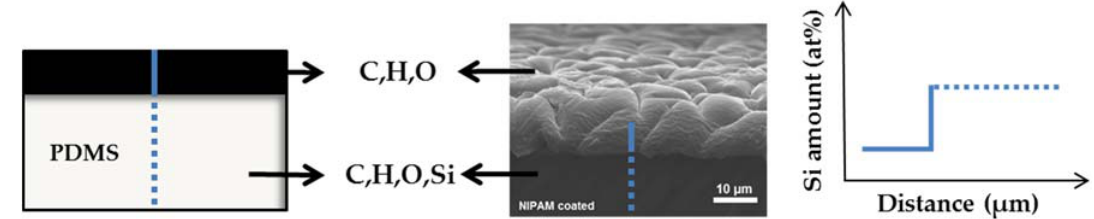
Figure 5. Scheme of Si amount determination from a cross section image of a coated PDMS surface obtained by SEM-EDX.